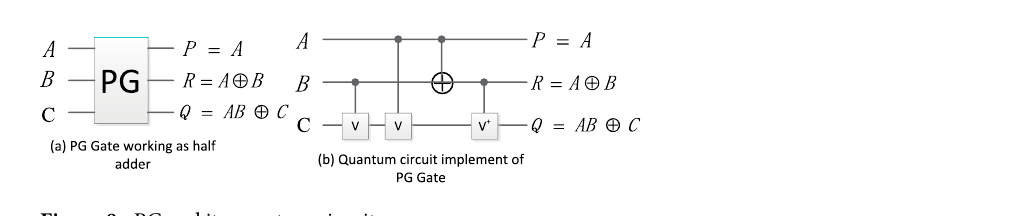
Figure 8. PG and its quantum circuit.